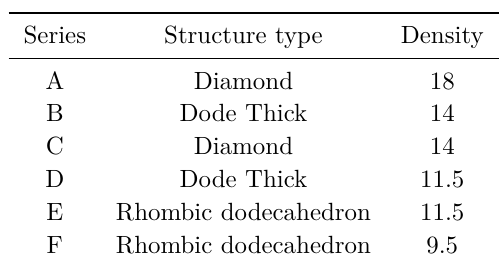
Table 1. Structure type of individual specimens and their density (basic element count).